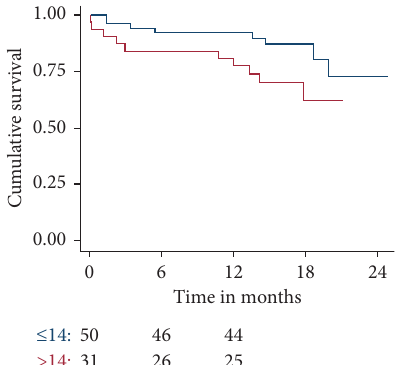
Figure 2: Cumulative survival of patients with postprocedural leucocytes (pL) > 14 vs. ≤ 14/nl. Further analysis showed a statis- tically nonsignificant trend towards a better outcome for patients with pL ≤ 14/nl ( p � 0.05).